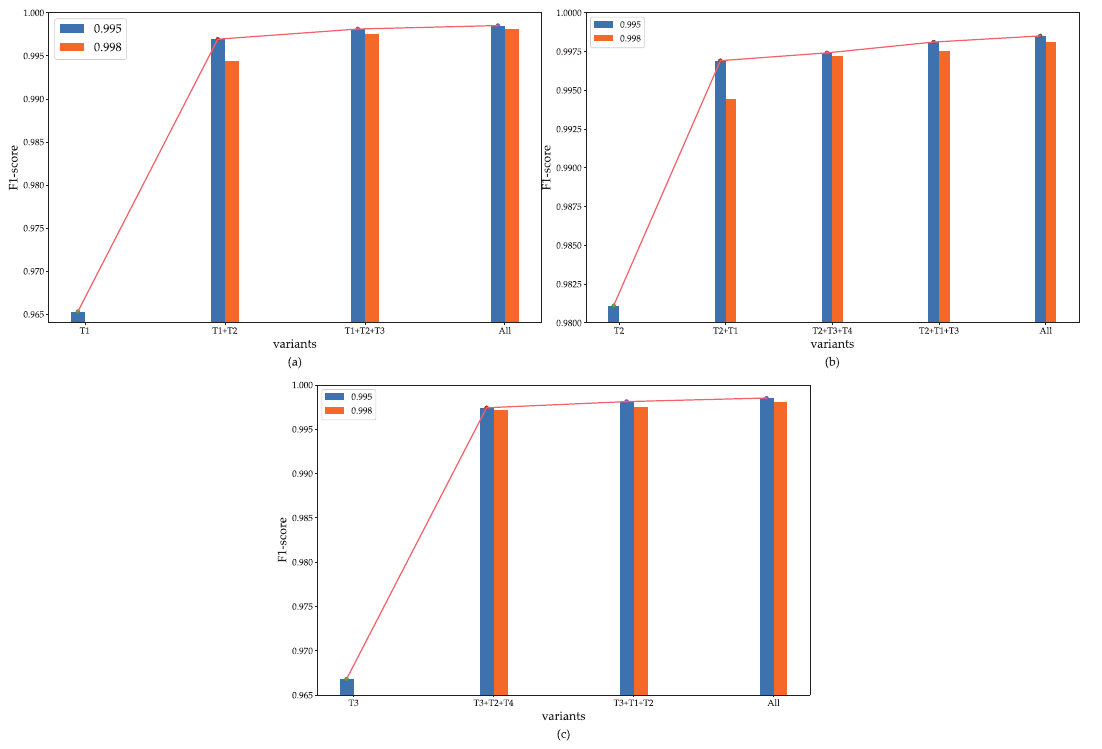
Figure 7. F1-scores for anomaly detection obtained by adding one proxy task at a time: ( a – c ) Ablation test results based on Tasks 1 ‒ 3, respectively.